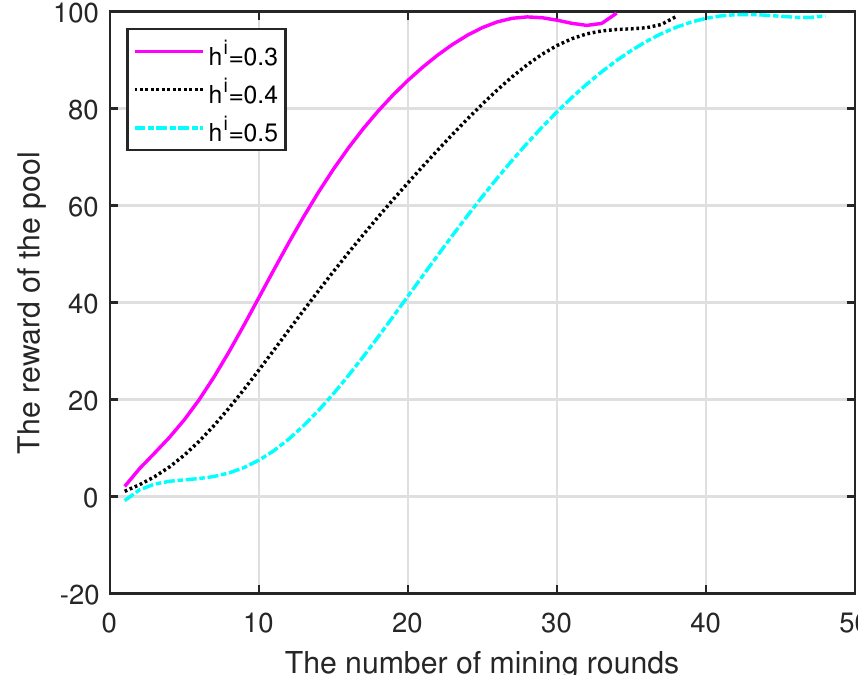
Figure 5. Mining rounds vs.